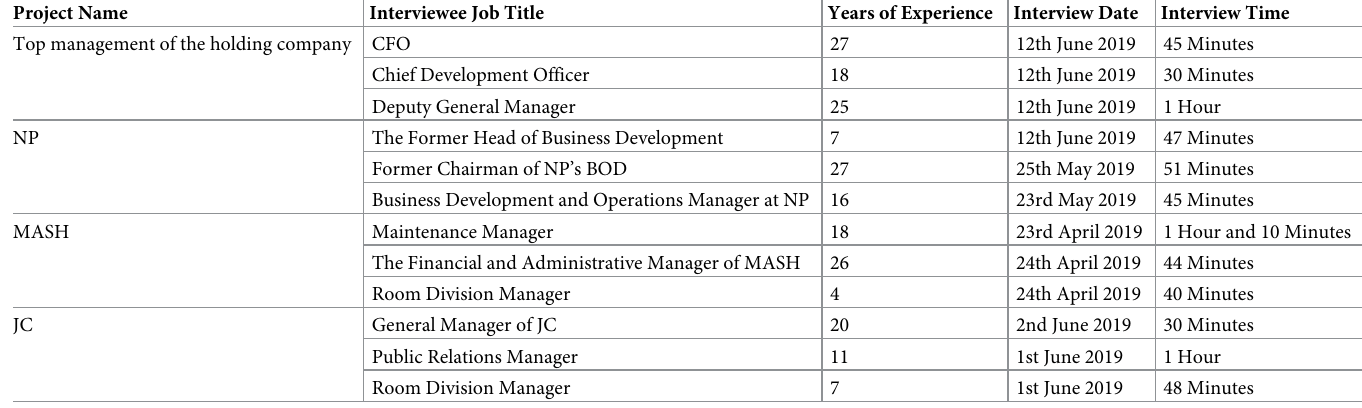
Table 1. Interviewees’